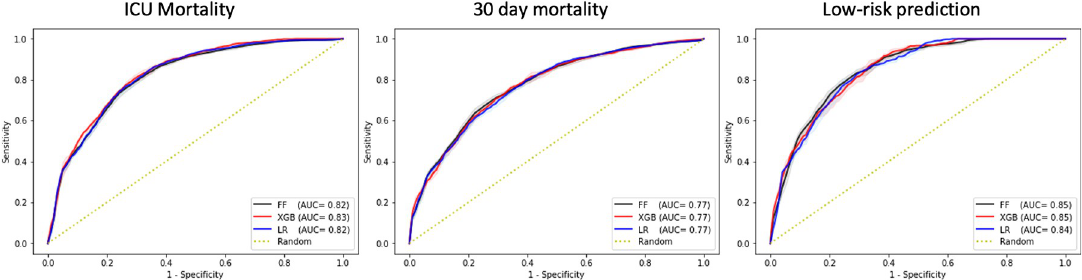
Fig 6. AUC performance of each model in the European cohort of patients admitted to ICUs after the cut-off date of Dec 1st, 2020 for each of the three outcomes. AUC and AUPRC performance graphs of each model in internal cross-validation are available in Fig B in S3 Text.